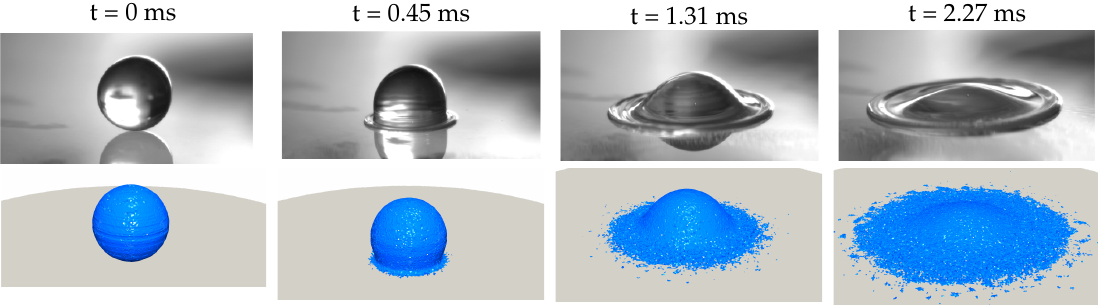
Figure 3. Case 0 validation study with a qualitative comparison of experimental and simulated results. Upper row : experimental results from Rioboo [41] Lower row : Case 0 simulated results.